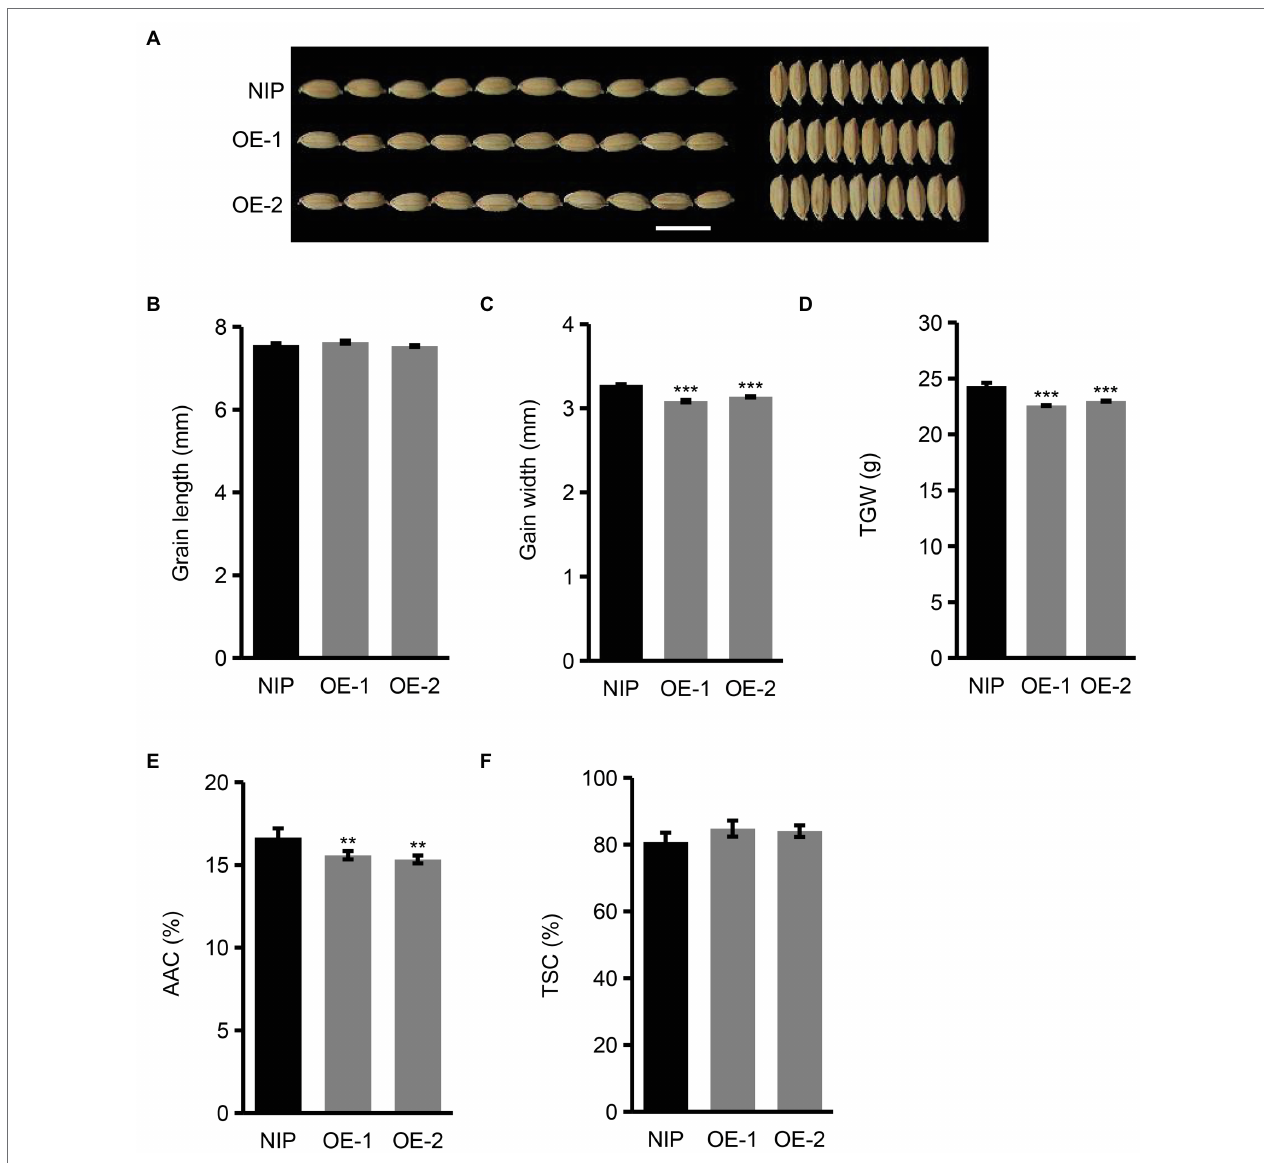
FIGURE 3 | Overexpression of OsNAC129 leads to reductions in grain size and apparent amylose content. (A) Phenotypic observation of WT and OE plants mature seeds. Scale bar = 10 mm. (B–D) Show grain length, grain width, and TGW of mature seeds of NIP and two OsNAC129 -OE lines, respectively. Data are means ± SD of three replicates. (E,F) Show the AAC and TSC of NIP and the two OsNAC129 -OE lines, respectively. Data are means ± SD of five replicates. ** p < 0.01, *** p < 0.001 as determined by Student’s t